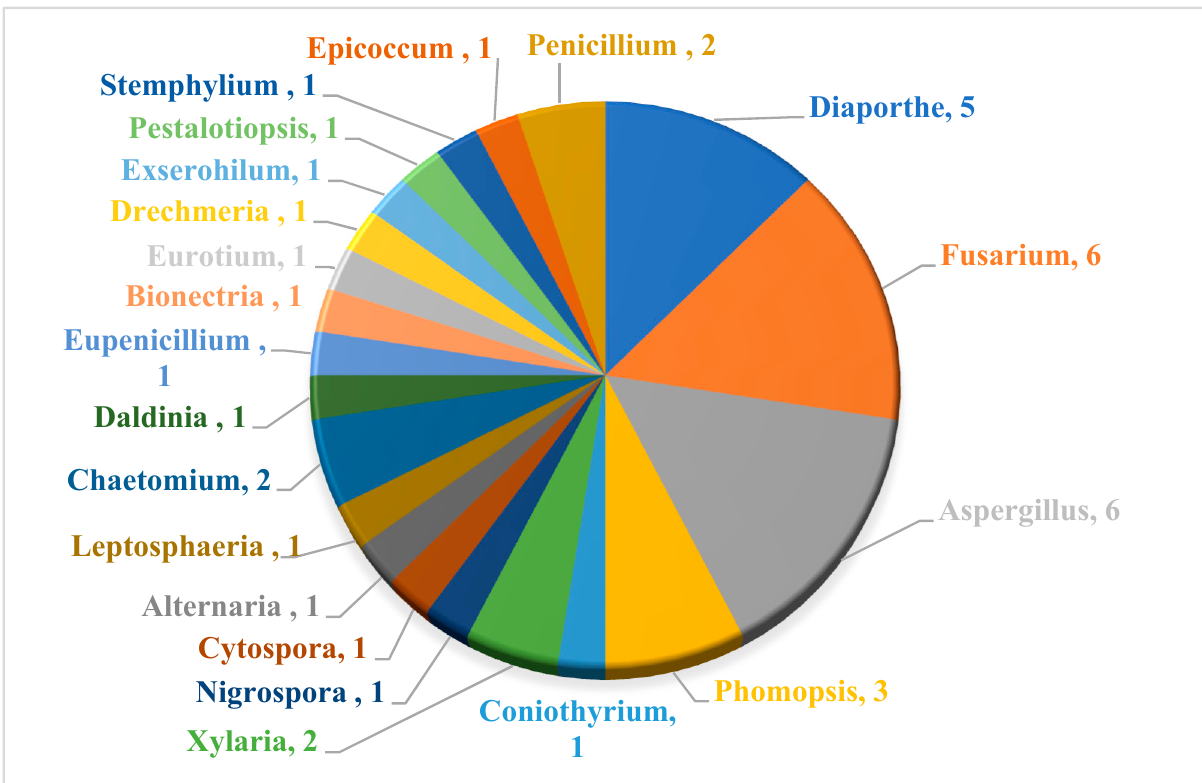
Figure 2. General graphic of the fungal endophytic genera surveyed in this review.